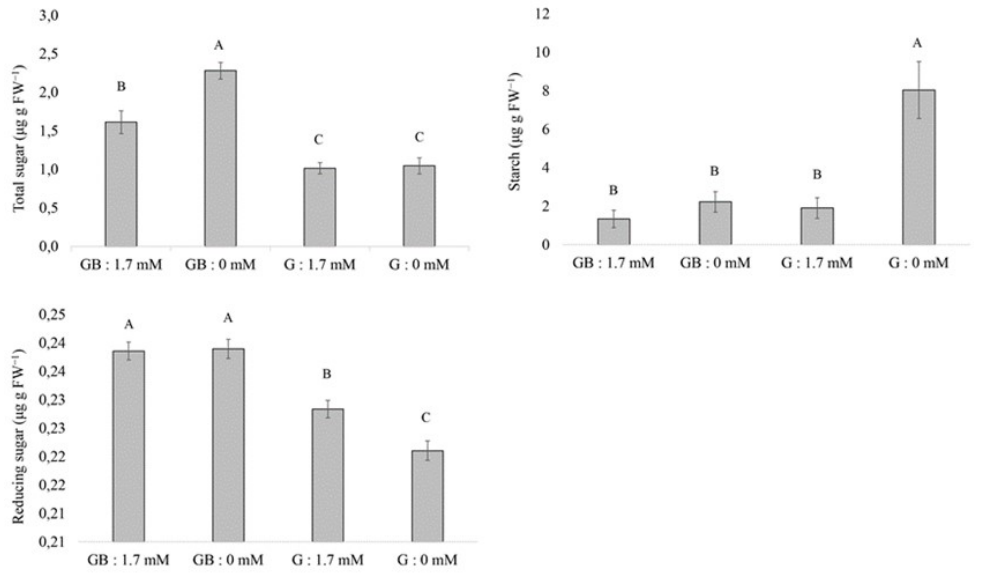
Figure 4. Carbohydrates, total soluble sugars ( µ g g FW − 1 ); starch ( µ g g FW − 1 ) and reducing sugar ( µ g g FW − 1 ) of Glycine–Bradyrhizobium and Glycine cultivated with 0 mM and 1.7 mM nitrate at 41 days after sowing. G, Glycine ; GB, Glycine–Bradyrhizobium